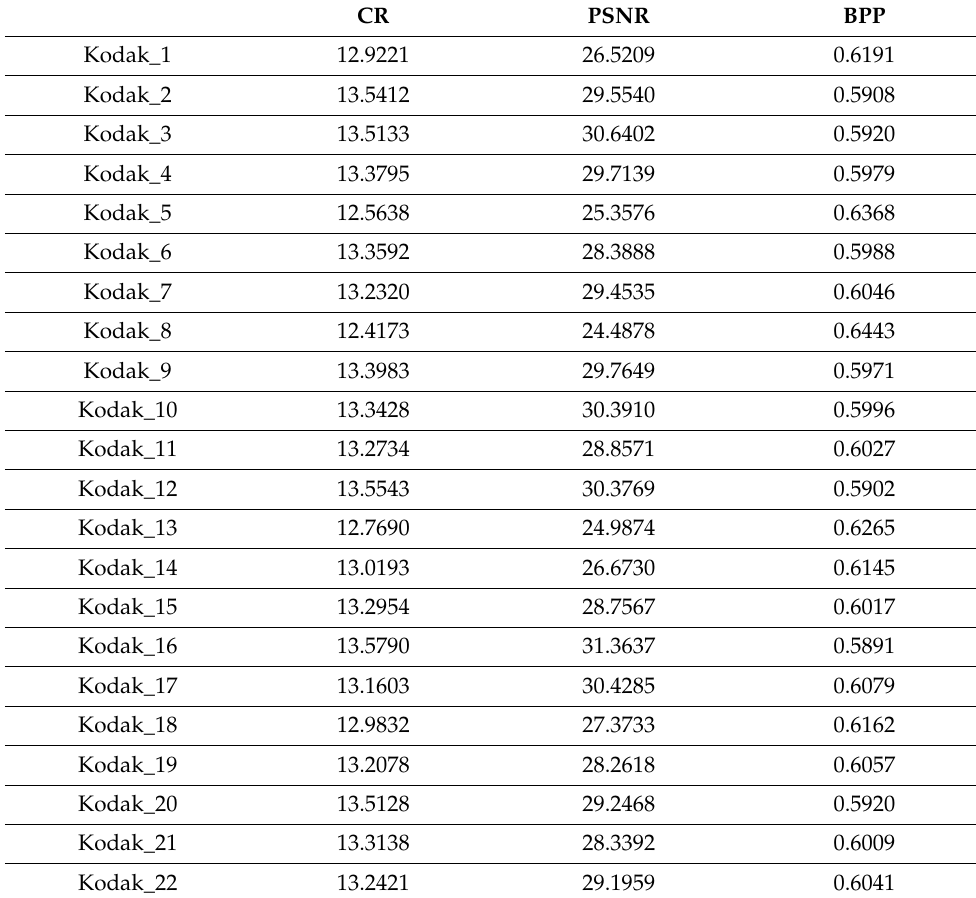
Table 5. Resulting in CR, PSNR, and BPP using the test images in Figure 14.